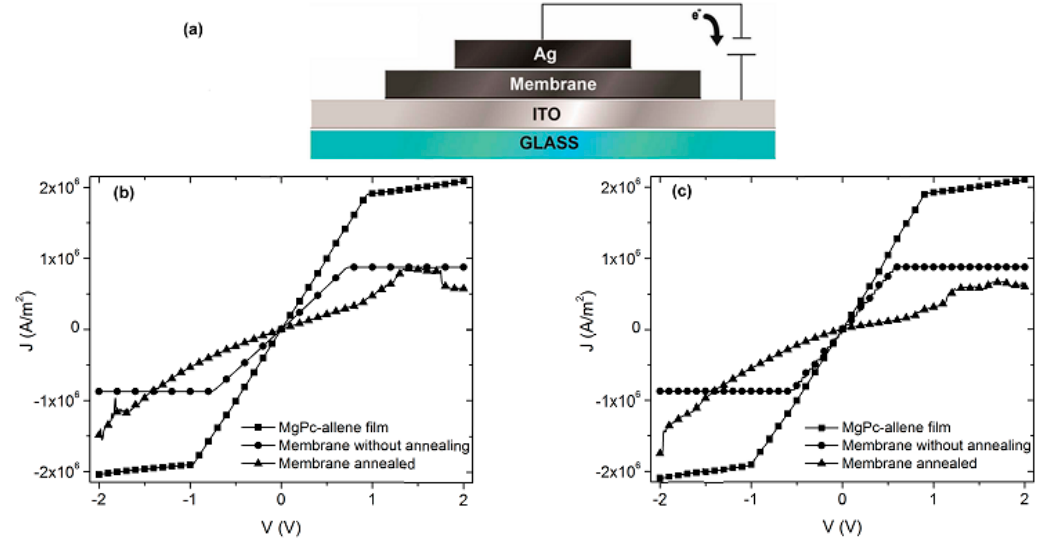
Figure 3. ( a ) Schematic structure of the electrical measurements in the membrane and thin film. J-V characteristics in ( b ) natural light conditions and ( c ) darkness conditions where ITO is positively biased.